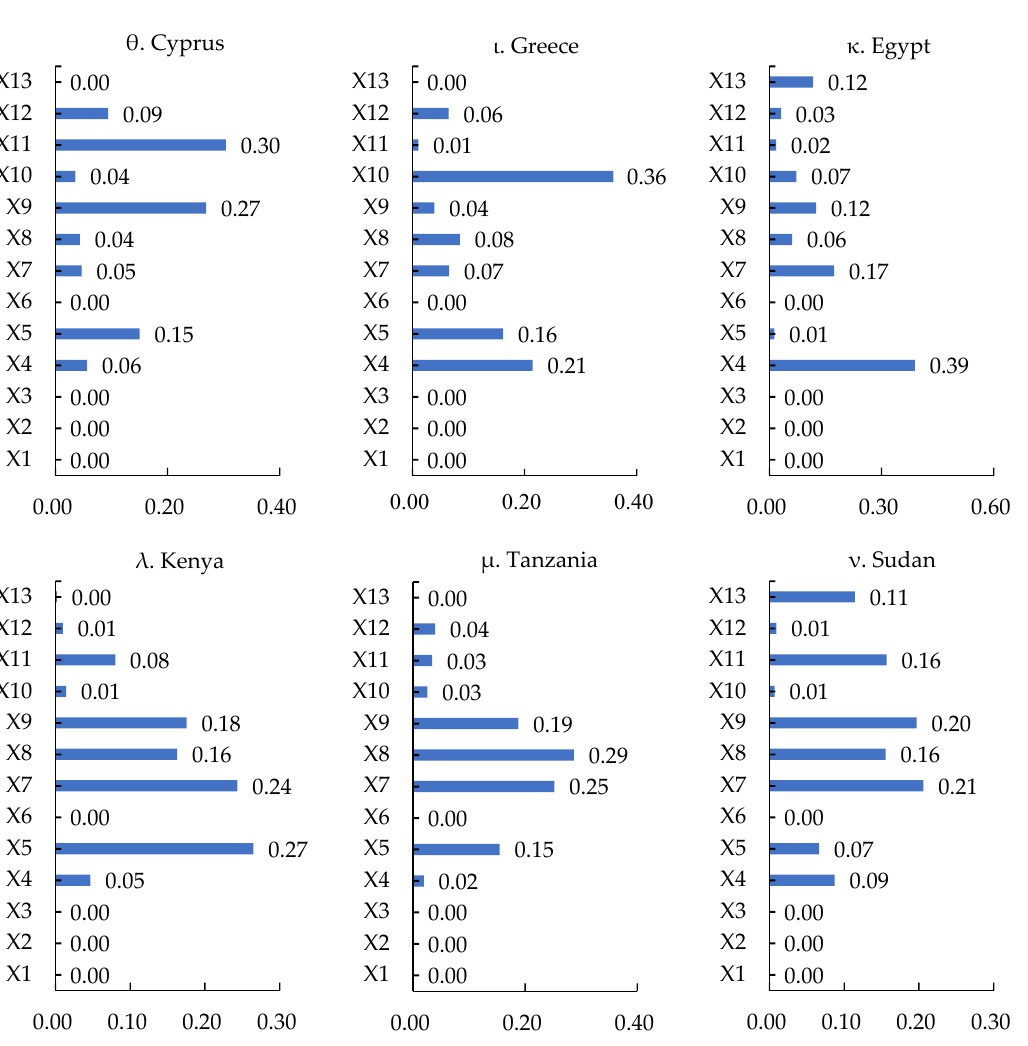
Figure 4. Type indices showing the characteristic importance of geo-economic relations between China and MSRCs. Note: The greater the value, the greater the importance of type indices.